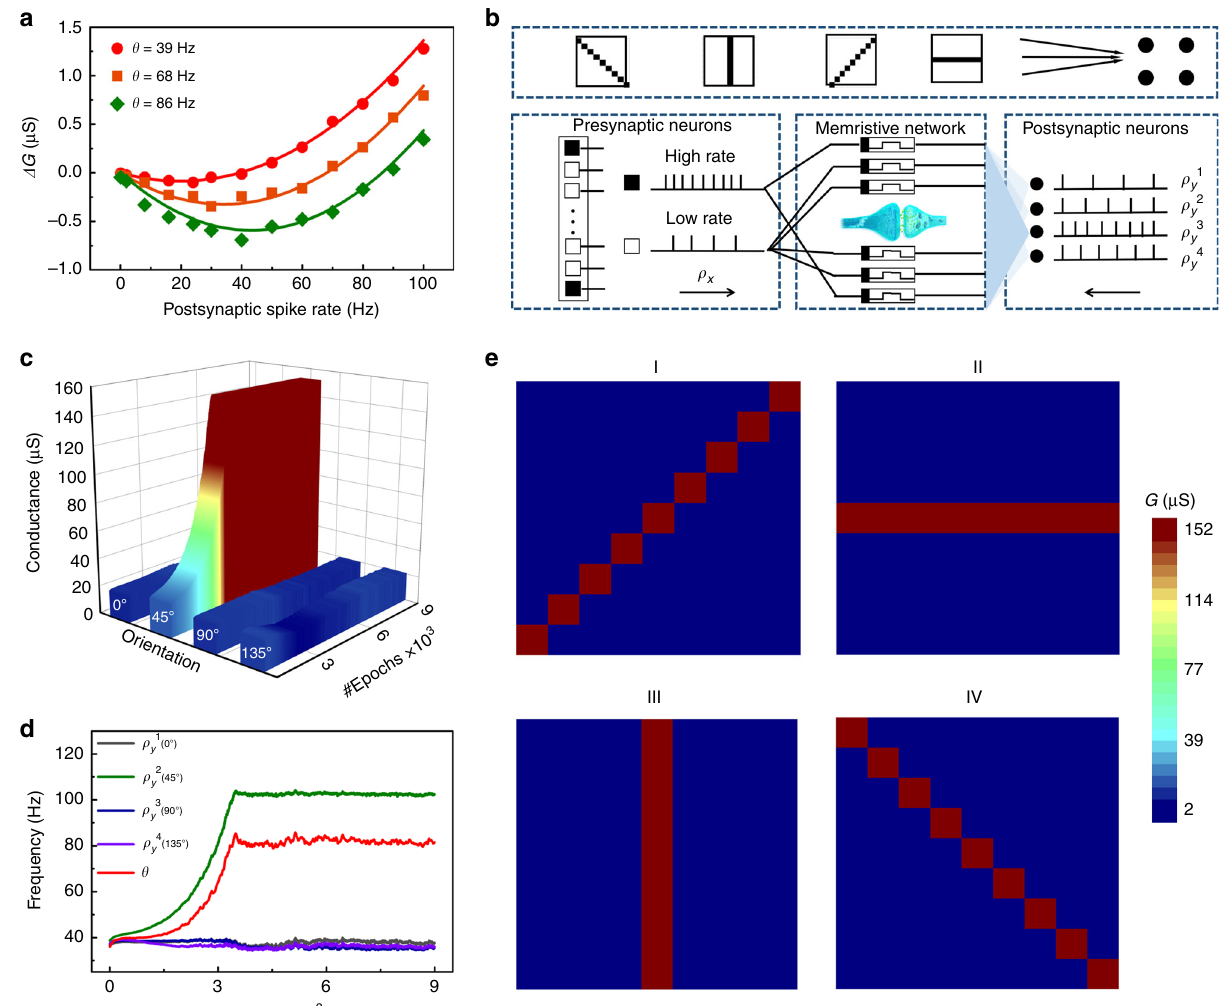
Fig. 4 Simulation of rate-based orientation selectivity using the triplet-STDP-based BCM model of Pt/WO 3 − x /W memristors. a Experimental data (dots) and calculated curves (lines) of BCM theory, which both have a good fi t. b Schematic illustration of the memristor-based feedforward neural network. Presynaptic spikes are generally Poisson spike trains with a mean rate < ρ x >. c The G 1 evolution of the extracted synapses only for the four orientations with the learning epochs. G 1 denotes the synaptic weight of the synapses connected to the 1st postsynaptic neuron. d Evolution of ρ y 1 corresponding to the four orientation bars with the learning epochs. e Color maps of the fi nal synaptic weights in the 9 × 9 memristor arrays which reveal the orientation selectivity for four postsynaptic